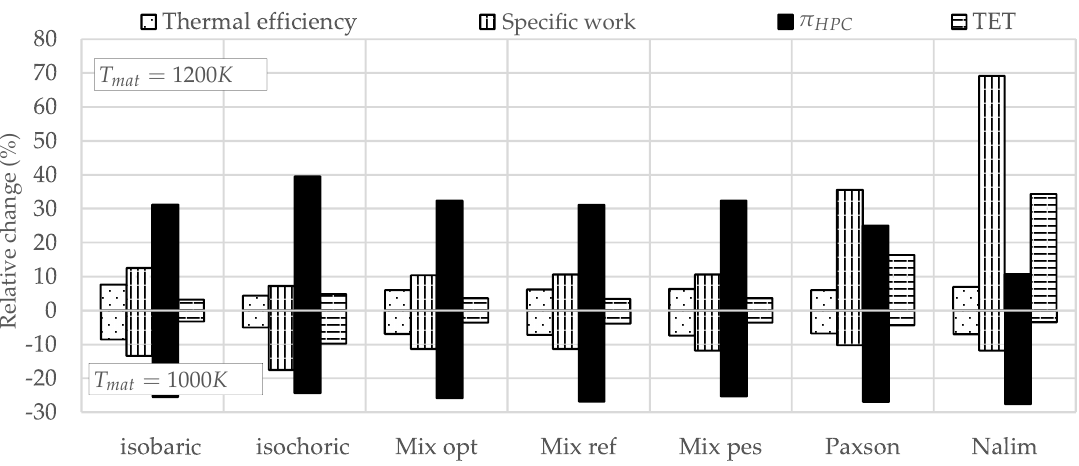
Figure 7. Engine specifications at T mat of 1200K ( top ) and 1000K ( bottom ) for the simple cycle. Table 4. Reference values at T mat = 1100 K for Figure